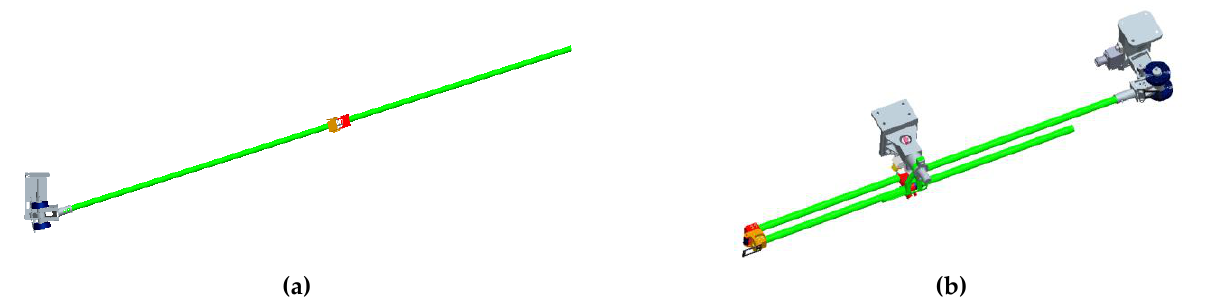
Figure 4. Deployment and folding mechanism. ( a ) Deployment status. ( b ) Folded status.